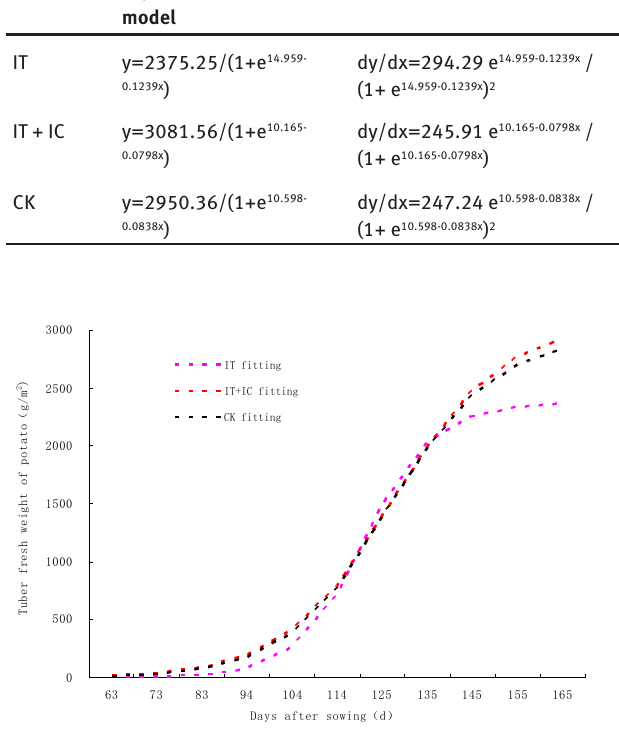
Figure 6: Dynamic simulation curve of fresh potato tuber in different treatments.